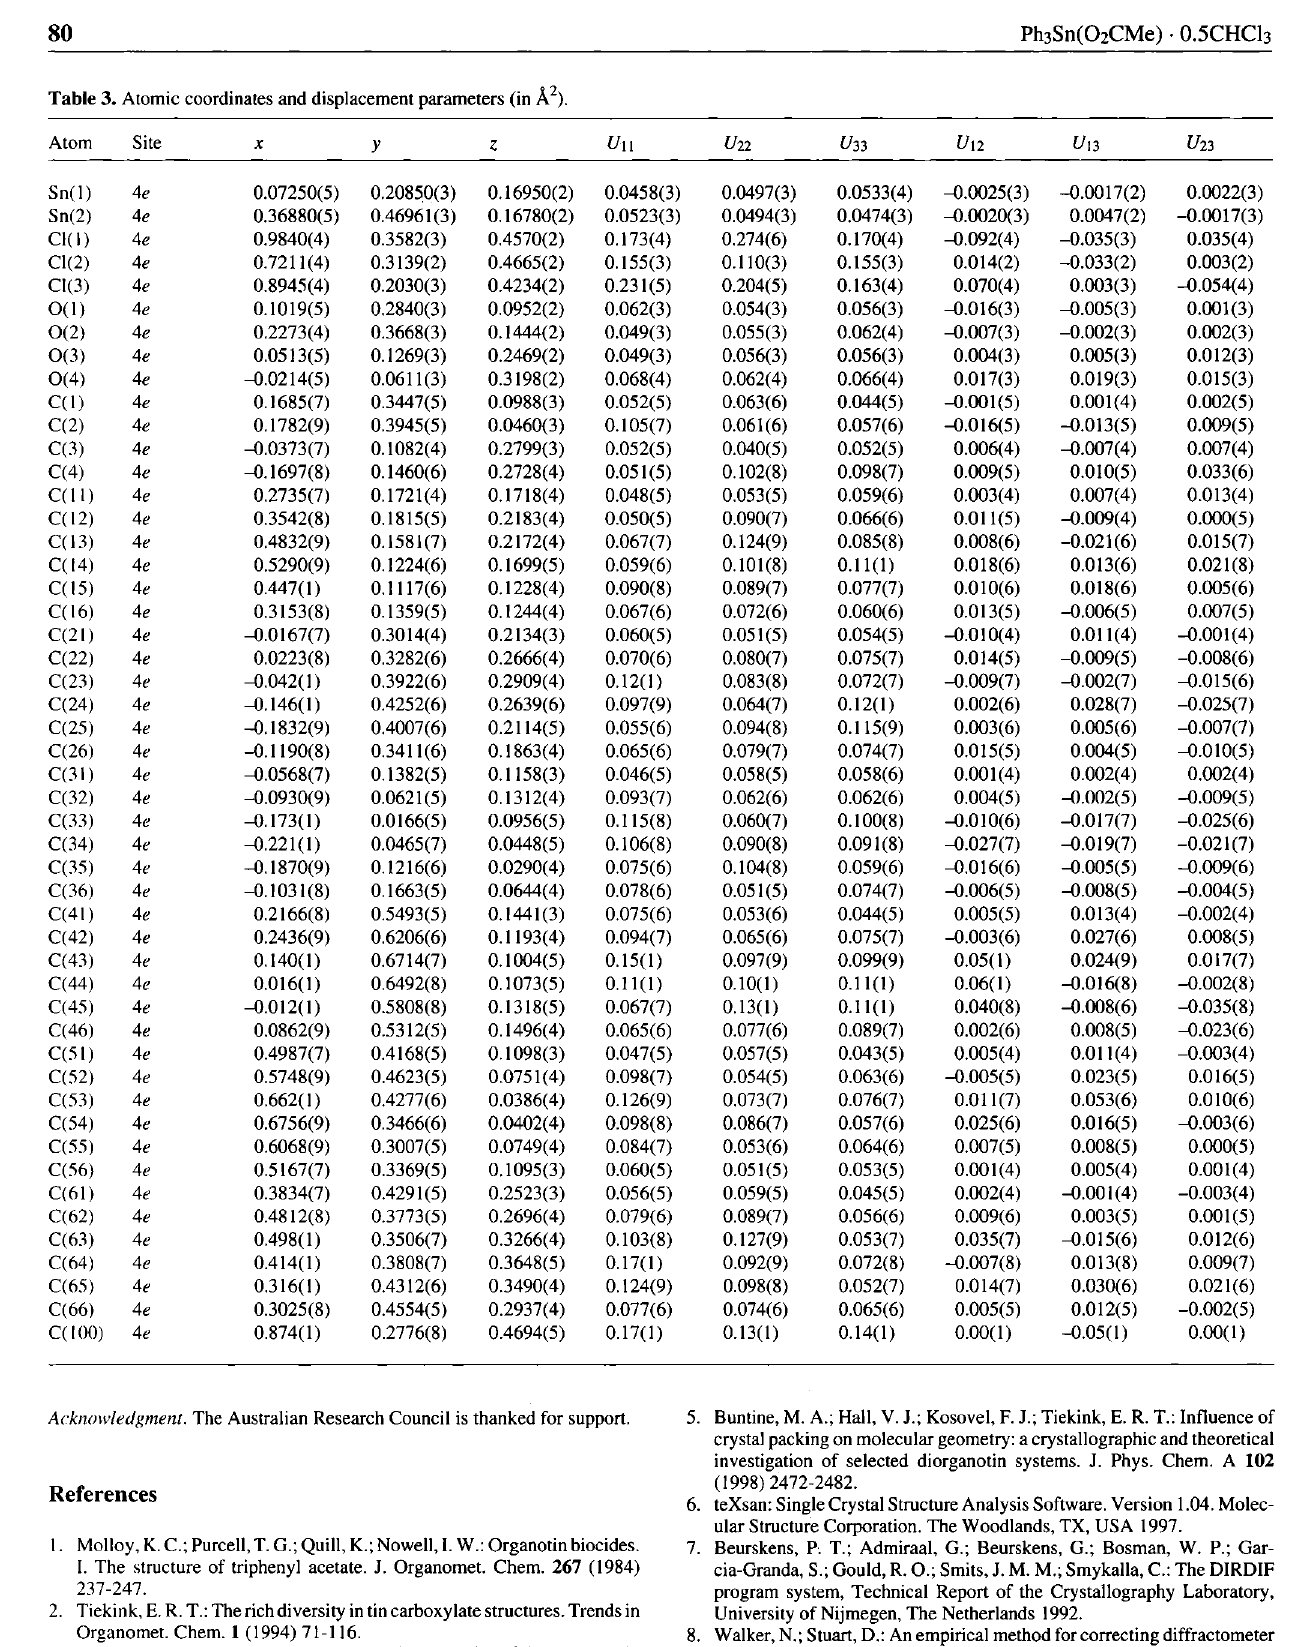
Table 3. Atomic coordinates and displacement parameters (in Ä 2 ).